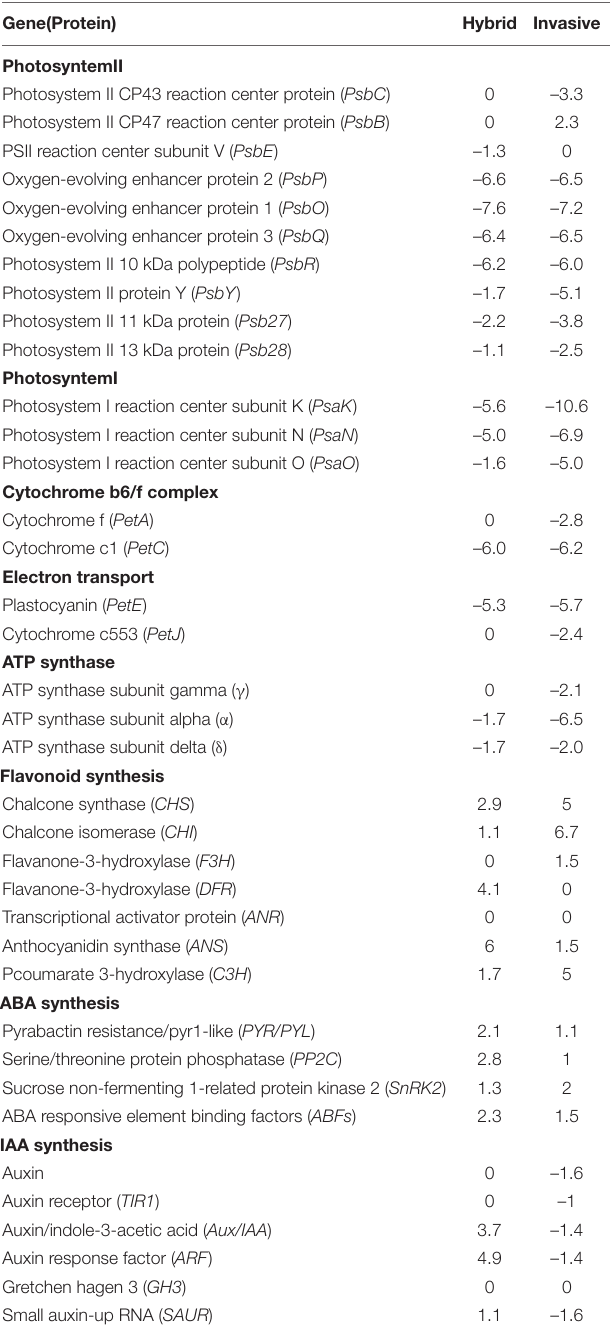
TABLE 3 | The expression multiples of key genes related photosynthetic, flavonoid synthesis, abscisic acid ABA and auxin IAA synthesis pathways in invasive species and hybrid under Cd stress.